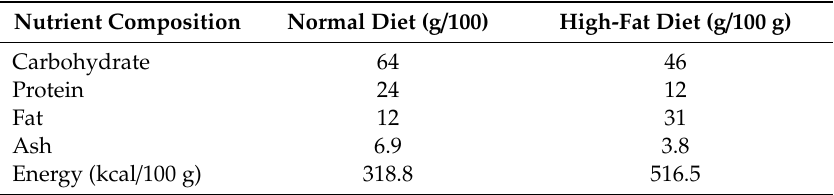
Table 1. Content of nutrients in normal and high-fat